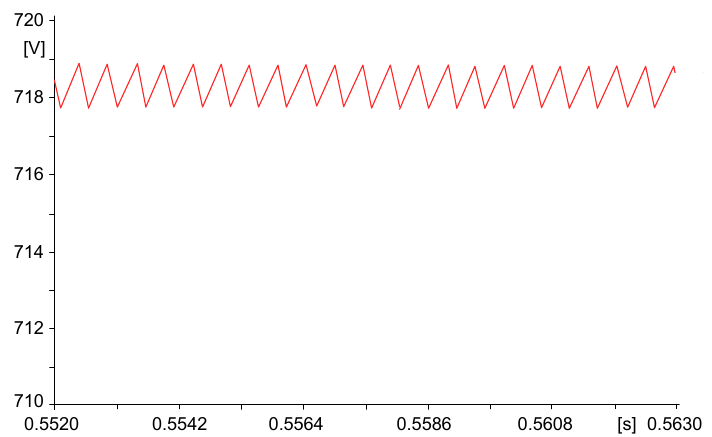
Figure 10. DC line voltage (two parallel DC/DC boost converters).